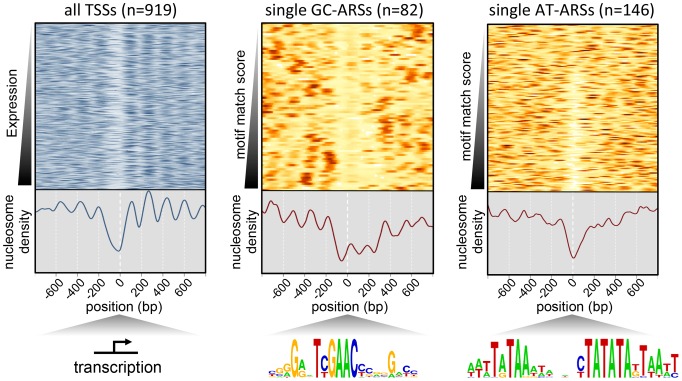
Nucleosome profile of P. pastoris.Nucleosome density is plotted for sites centered on all TSSs as a control to test the overall quality of the mapping data (left), non-overlapping GC-ARS sites with a single match to the GC-ACS (middle), or the A/T-rich motif shown in Figure 3C (right). TSS sites are ranked based on expression in the SDEG condition [55]. GC-ARS and AT-ARS sites are ranked by the strength of the best match to the G/C- and the A/T-rich motif respectively.